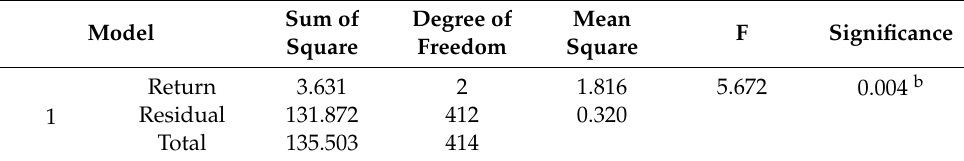
Table 15. Variance Analysis a .